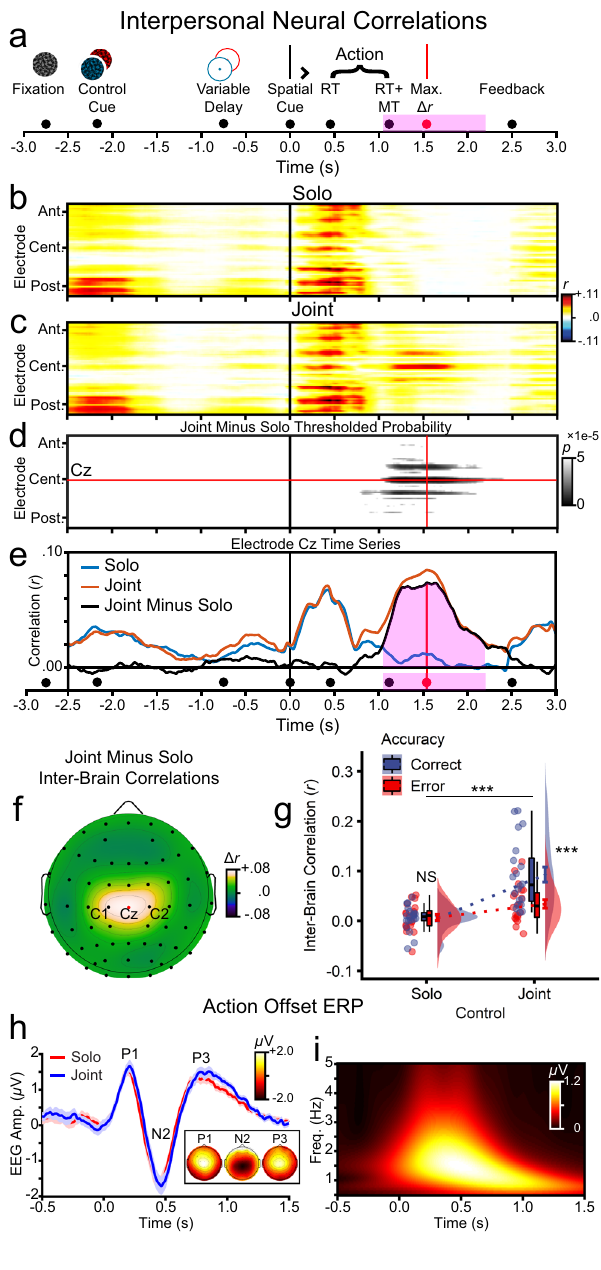
coloured bands) were maximal at two time points, fi rst during an early period coincident with the onset of the fi xation placeholder and action control cue, and second during a later period following the onset of the spatial cue. The earlier period revealed maximal correlations at posterior (i.e., occipitoparietal) electrodes, con- sistent with visual ERPs to the onset of fi xation and control cues. Interpersonal neural correlations at the later time period, fol- lowing the spatial cue, were much more topographically dis- persed, encompassing posterior, central, and anterior electrodes. of temporally overlapping cognitive processes, including visual band of correlated activity, apparent only for joint control, that appeared later in the trial, peaking following action completion (i.e., experiment mean RT + MT; Fig. 8c).